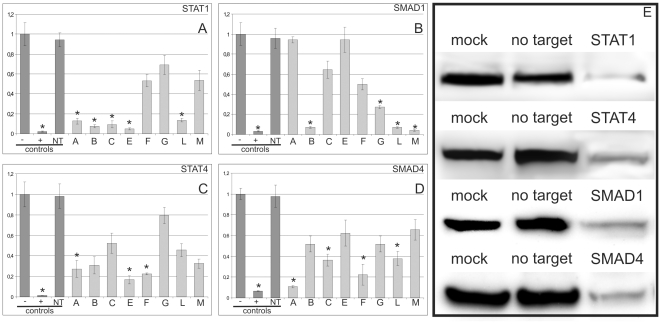
The consequences of STAT and SMAD downregulation on FA gene expression in HeLa cells.(A) The strongly reduced mRNA expression of FANCA, -B, -C, -E and -L following STAT1 knockdown in the respective FANC gene (FANCA, -B, -C, -E, -F, -G, -L and M correspond to lanes 1–8, respectively). (B) The SMAD1 knockdown results in decreased levels of FANCB, -G, -L and -M mRNAs. (C) The mRNA levels of FANCA, -E and -F were reduced following the siRNA treatment directed against STAT4. (D) Following the SMAD4 inactivation, FANCA, -C, -F and -L exhibited reduced mRNA levels. (E) A western blot showing the effective transcription factor knockdown. The first three columns denote the controls as follows: (−) untransfected HeLa cells, (+) knockdown using siRNA directed against the gene of interest, and (NT) transfection with a non-targeting siRNA. All the results were derived from triplicate assays. *p<0.05.